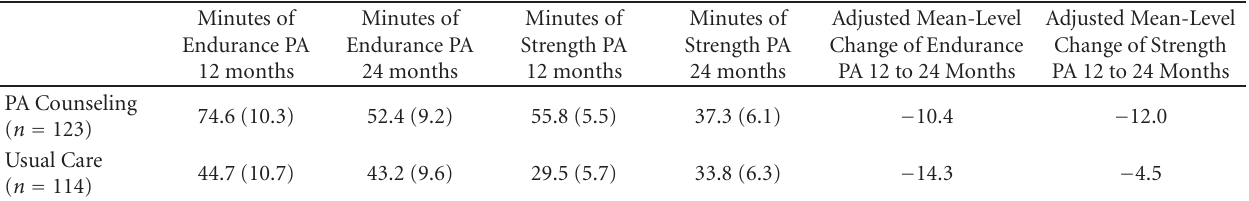
Table 1: Minutes of strength and endurance PA at 12 and 24 months by intervention group in participants who completed the 24-month